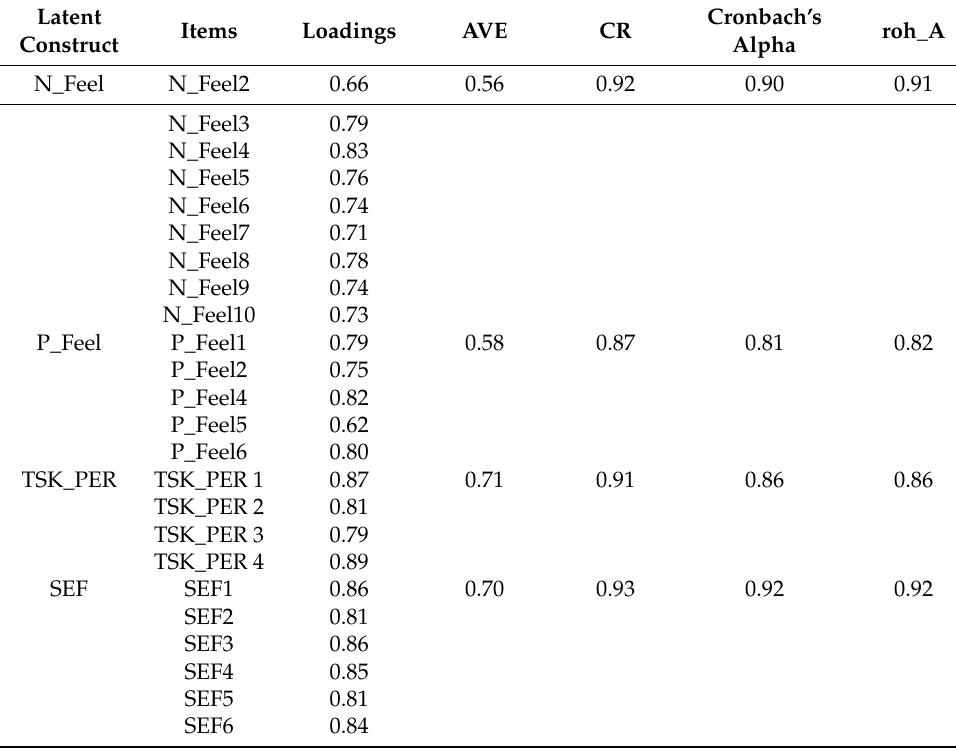
Table 4. Internal consistency and reliability and convergent validity.